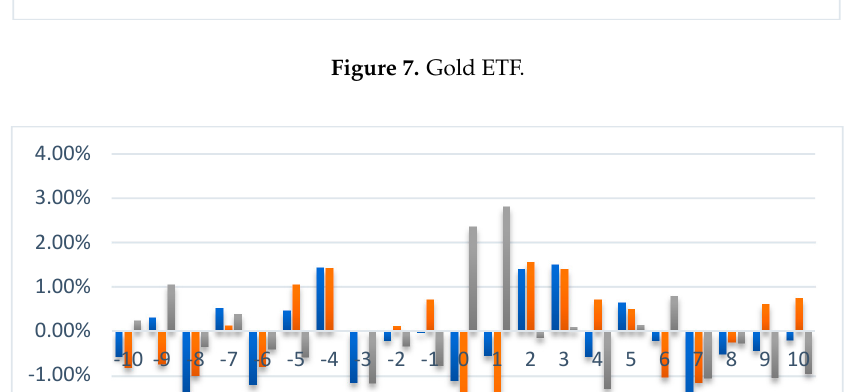
Figure 7. Gold ETF.